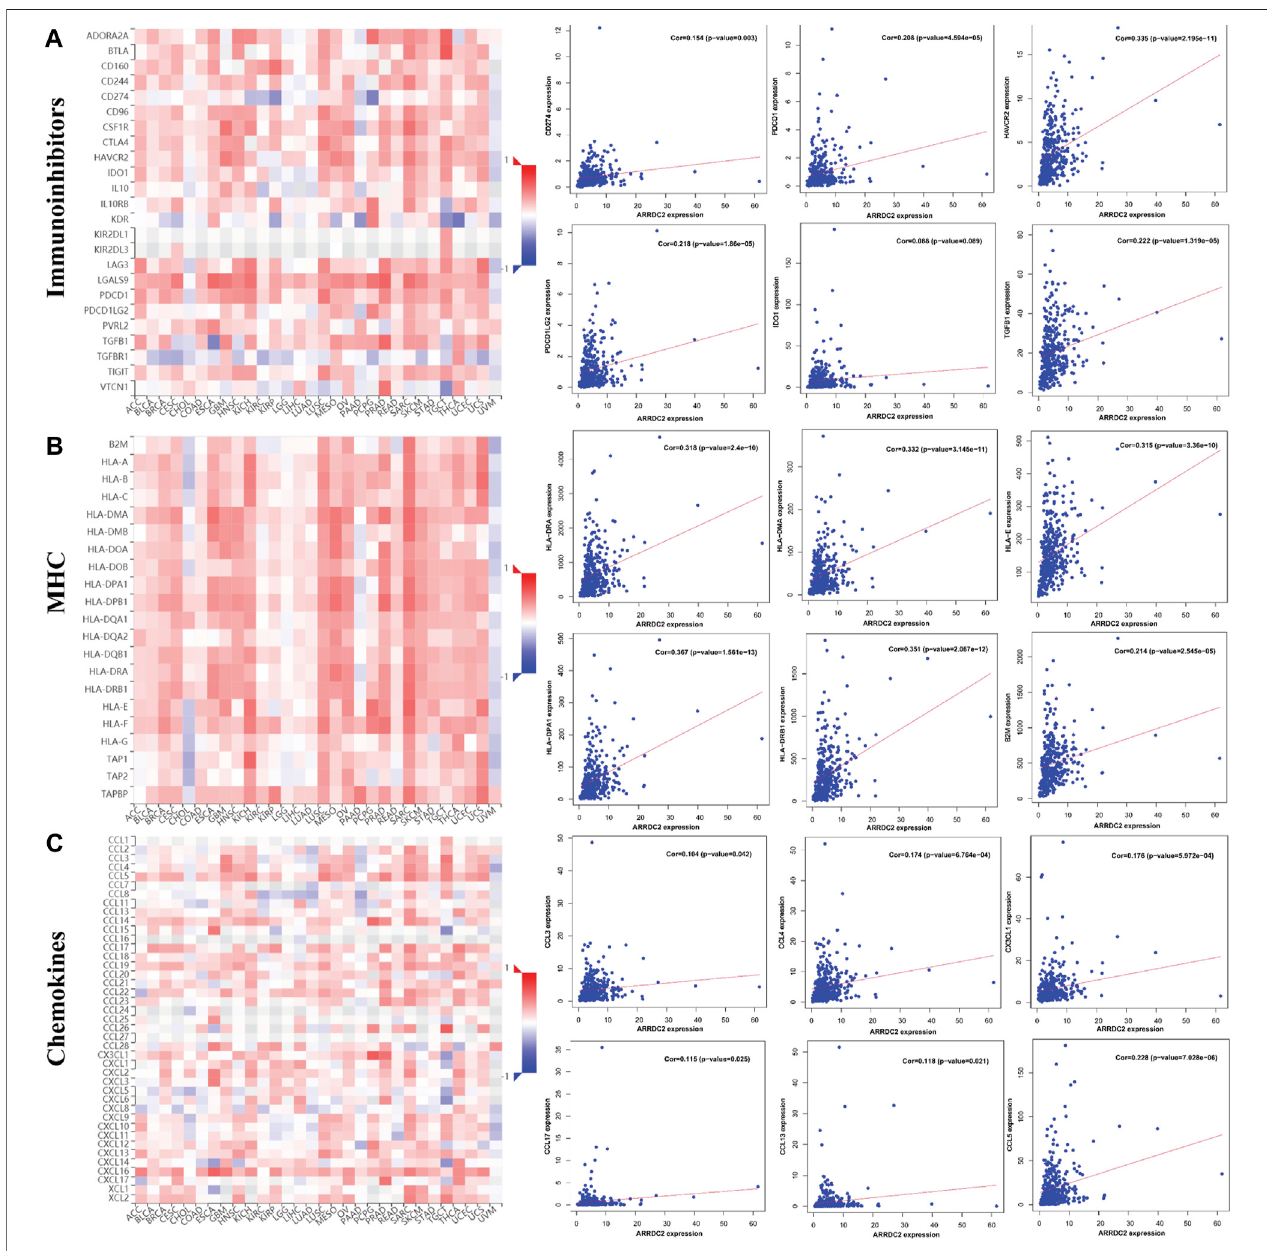
FIGURE 5 | The relationship between the expression of ARRDC2 and immune checkpoints, MHC and chemokines in the TISIDB database. (A) The relationship between immune checkpoint (CD274, HAVCR2, IDO1, PDCD1, PDCD1LG2, TGFB1) and ARRDC2 gene expression. (B) The relationship between MHC (B2M,